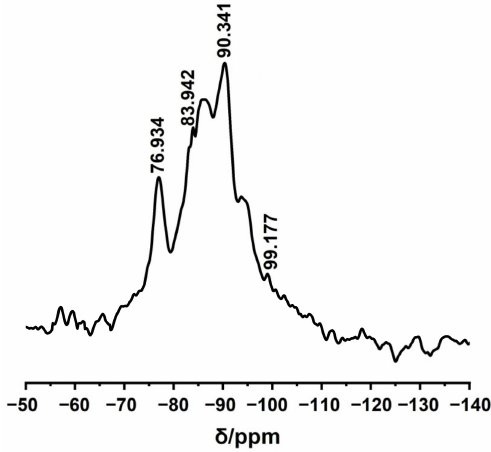
Figure 5. 29 Si NMR spectra of MBG